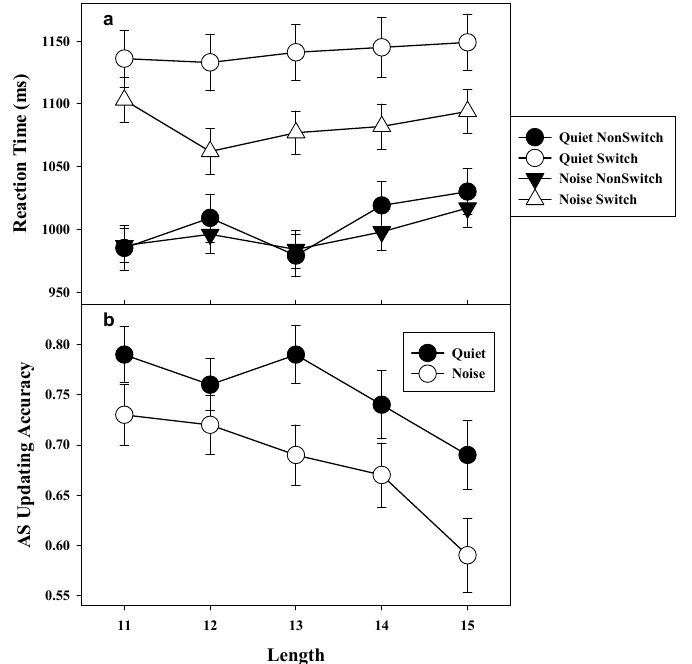
Figure 1. Mean switch and nonswitch reaction time by condition and set length (panel ( a )). Mean attention switching updating accuracy by set length (panel ( b )). Error bars depict one standard error of mean. AS = Attention Switching.